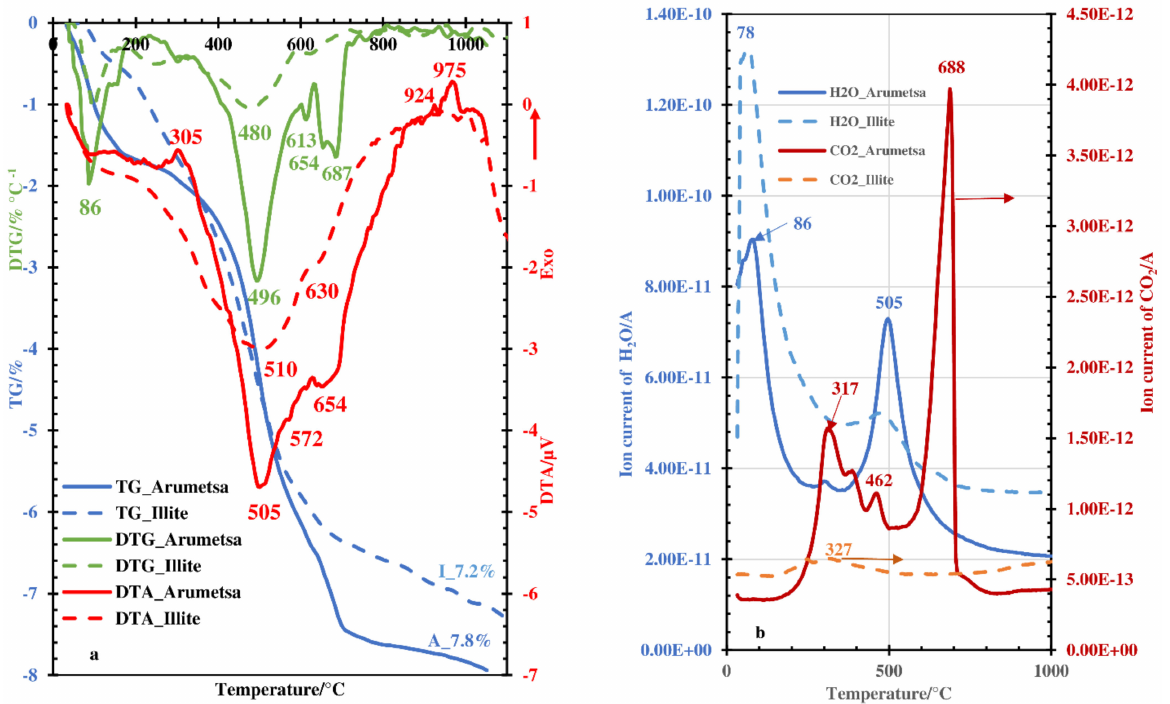
Figure 1. Thermoanalytical curves ( a ) and emission profiles of H 2 O and CO 2 ( b ) emitted upon thermal treatment of Arumetsa and illitic